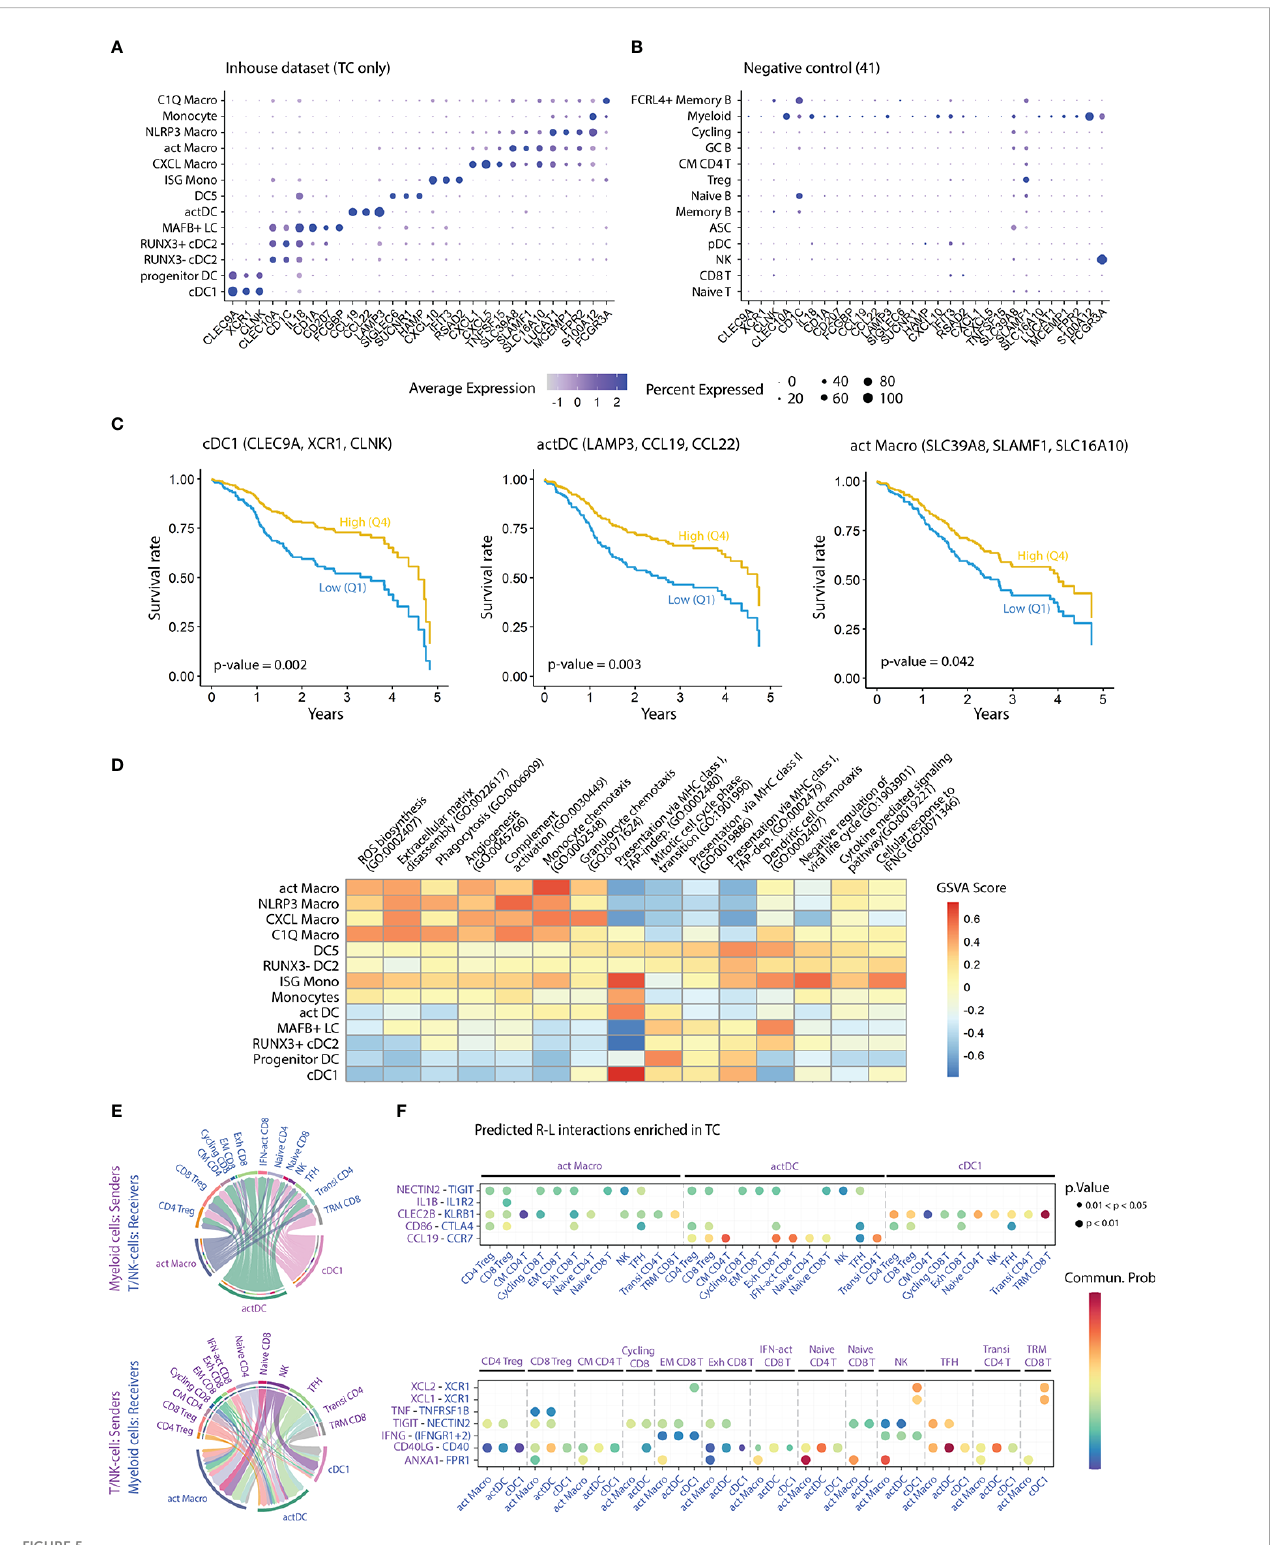
FIGURE 5 Impact of myeloid populations on patient survival, as well as functions and interactions thereof. (A) Dot plot displaying cluster-speci fi c signature genes in the myeloid dataset and (B) in a publicly available scRNA-seq dataset (41). (C) Survival curves showing fi ve-year overall survival rates for the indicated gene-sets, from a publicly available bulk RNA-seq dataset of HNC patients (n=529) (52). Comparison of survival probability was performed using log-rank test and Cox proportional-hazards model. Years: years since diagnosis. (D) Heatmap colored by GSVA score of enriched GO pathways in the myeloid clusters (adjusted p-value < 0.05). (E) Chord diagrams displaying the interaction between cell pairs. Interaction strength is presented as the weight of the edges, and the receiver cell cluster is indicated by the apex of the arrow. (F) Bubble plot showing statistically signi fi cant receptor-ligand (R-L) coding gene pairs in TC between myeloid cell subsets and T/NK- cells from a publicly available dataset (41). GSVA, gene set variation analysis; FC, fold change; p, p-value; CM, central memory; EM, effector memory; Exh, exhausted; IFN-act, IFN-activated; NK, natural killer; TFH, T follicular helper; Transi, transitional; TRM, tissue-resident